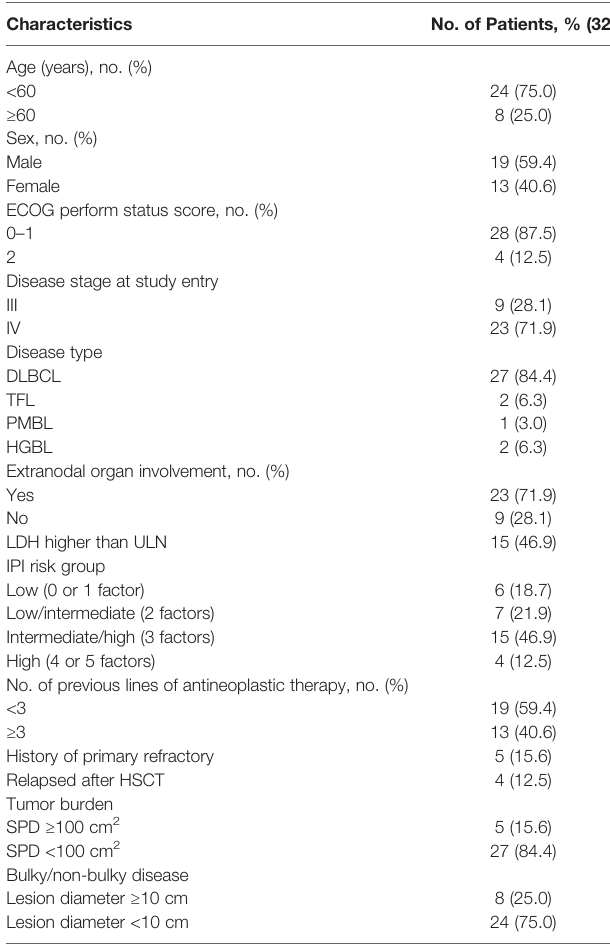
TABLE 1 | Patient Demographic and Baseline Disease Characteristics.